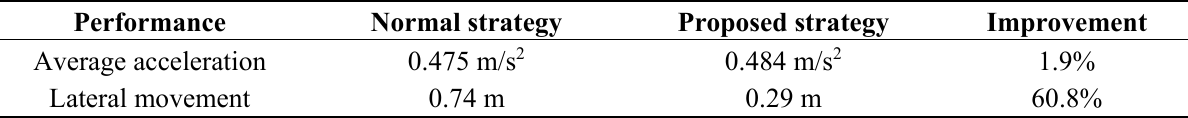
Figure 13. Comparison of simulation results of proposed strategy and normal strategy on variation split- μ road: ( a ) lateral movement and ( b ) acceleration performance. Table 6. Driving performance comparison on variation split- μ road